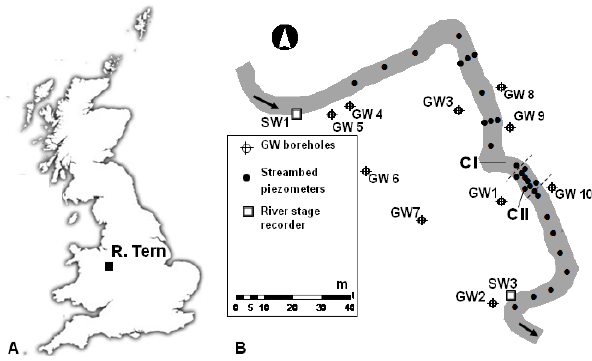
Fig. 1. (A) : field site location in the UK and (B) : experimental de- sign at the River Tern with groundwater boreholes (GW), surface water gauges (SW) and the streambed piezometer network. The lo- cations of exemplary sediment cores CI and CII are indicated in close vicinity to the pronounced pool-riffle-pool area, investigated by Krause et al. (2011b) (indicated by hatched